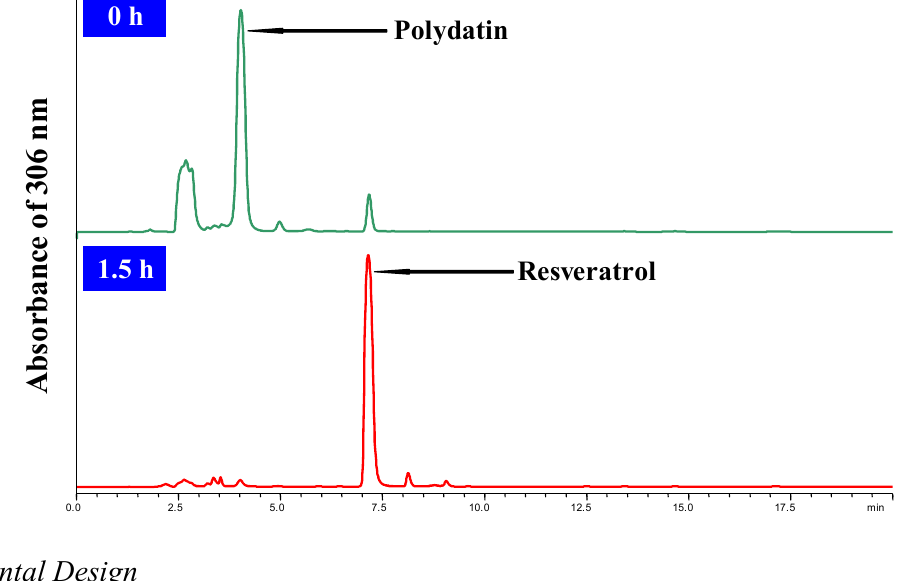
Figure 5. HPLC analysis of the bioconversion of polydatin to